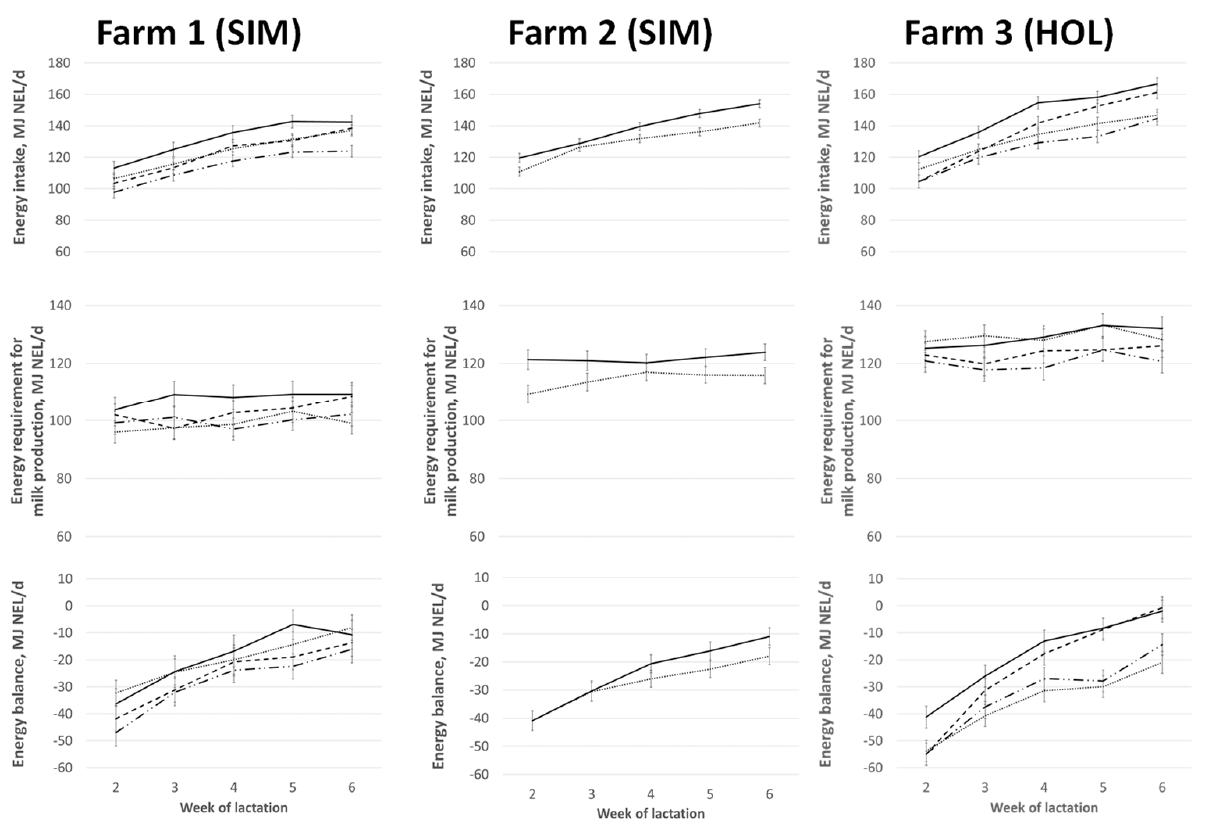
Figure 1. Development of energy intake, the energy requirement for milk production and mainte- nance, and energy balance during weeks 2 and 6 of lactation in different feeding groups; feeding groups: (1) — ∙ ∙ — moderate energy concentration of roughage (6.1 MJ NE L /kg DM) and a moderate amount of concentrates (150 g/kg ECM), (2) — — — moderate energy concentration of roughage (6.1 MJ NE L /kg DM) and high amount of concentrates (250 g/kg ECM), (3) ∙∙∙∙ high energy concen- tration of roughage (6.5 MJ NE L /kg DM) and a moderate amount of concentrates (150 g/kg ECM), and (4) — high energy concentration of roughage (6.5 MJ NE L /kg DM) and high amount of concen- trates (250 g/kg ECM) .